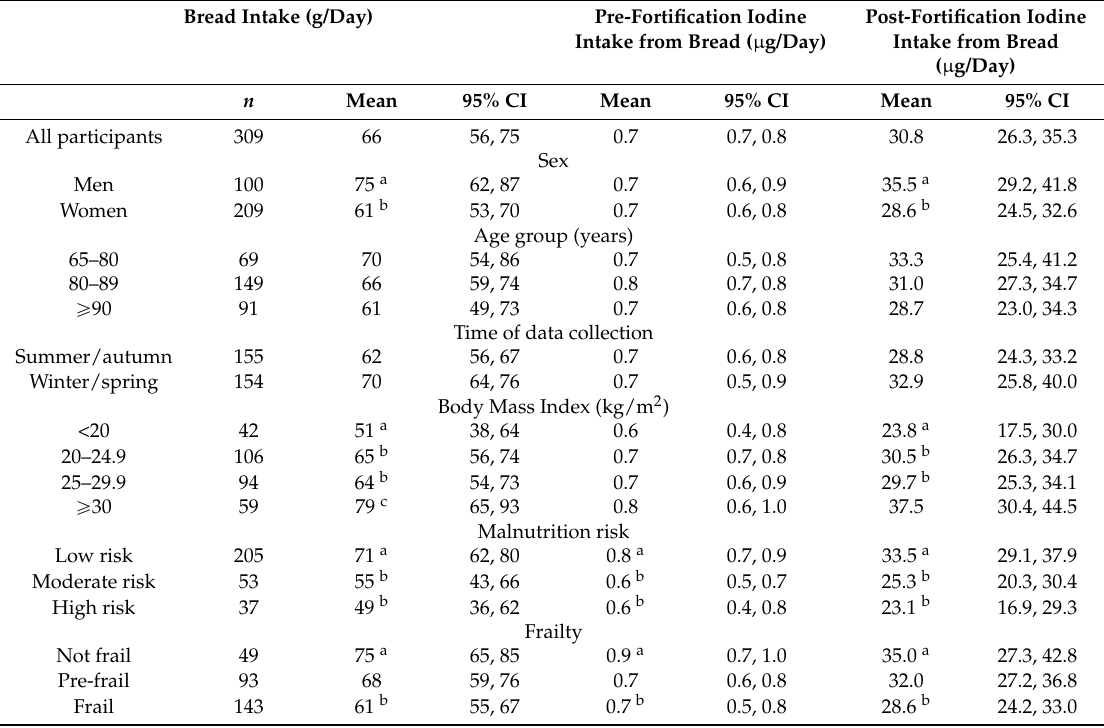
Table 5. Bread and iodine intake by elderly New Zealand rest home residents before and after iodine fortification of bread